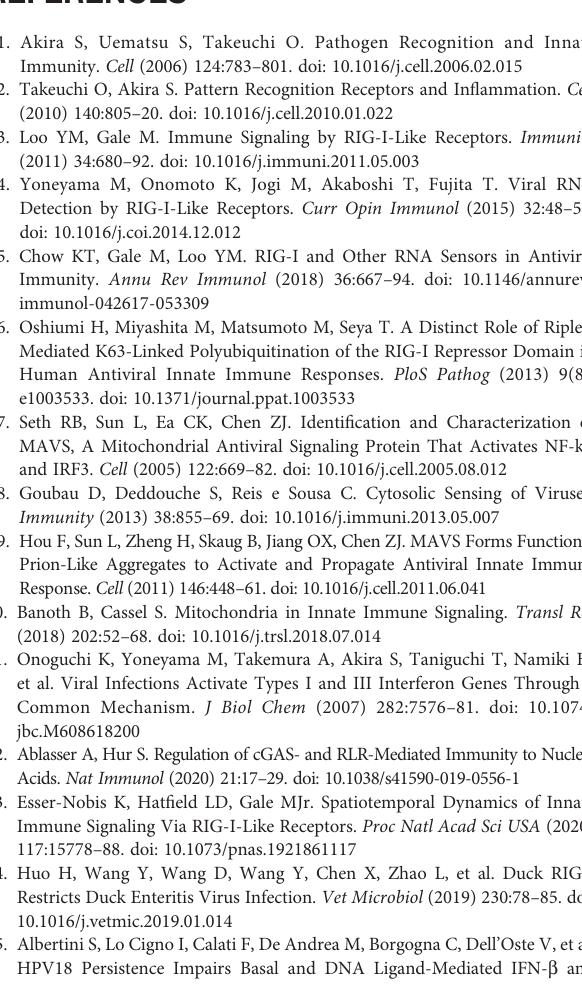
samples; lanes 6-9: healthy bladder samples; in the last channel: negative control (RNAwithoutreversetranscriptasesubjectedtoPCRanalysis). (B) Thelowerpartof the fi gureshows the alignment ofthe sequences, whichrevealed 100%identity with bovine TRIM25 transcript sequences deposited in GenBank (Bos taurus tripartite motif containing 25 (TRIM25), mRNA: NM_001100336.1). Supplementary Figure 3 | (A) RIG-I and MDA5 cDNA ampli fi cation by PCR in normalandinfected bovineurinary bladdersamples compared with b -actin.Lane1: molecular weight marker (DNA marker ladder); lanes 2-5: four representative infected bladder samples; lanes 6-9: healthy bladder samples; in the last channel: negative control (RNA without reverse transcriptase subjected to PCR analysis). (B) The lower part of the fi gure shows the alignment of the sequences, which revealed 100% identity with bovine RIG-I and MDA5 transcript sequences deposited in GenBank (Bos taurus DExD/H-box helicase 58 (DDX58), transcript variant X1, mRNA: XM_002689480.6; Bos taurus interferon induced with helicase C domain 1 (IFH1), mRNA: XM_010802053.2). Supplementary Figure 4 | Relationship between viral load (x axis) and protein expression levels (y axis). A – Riplet; B -TRIM25; C – MDA5; D- RIG-I; E- Sec13; F- IRF3; G-TBK1; H-pTBK1. Pearsons ’ s p value was not statistically signi fi cant. Supplementary Figure 5 | Relationship between viral load (x axis) and mRNA expression levels (y axis). A – MDA5; B -RIG-I: C-TRIM25; D- IKK a ; E- IKK b ; F- IKK g ; G – IFN b . Pearsons ’ s p value was not of statistical signi fi